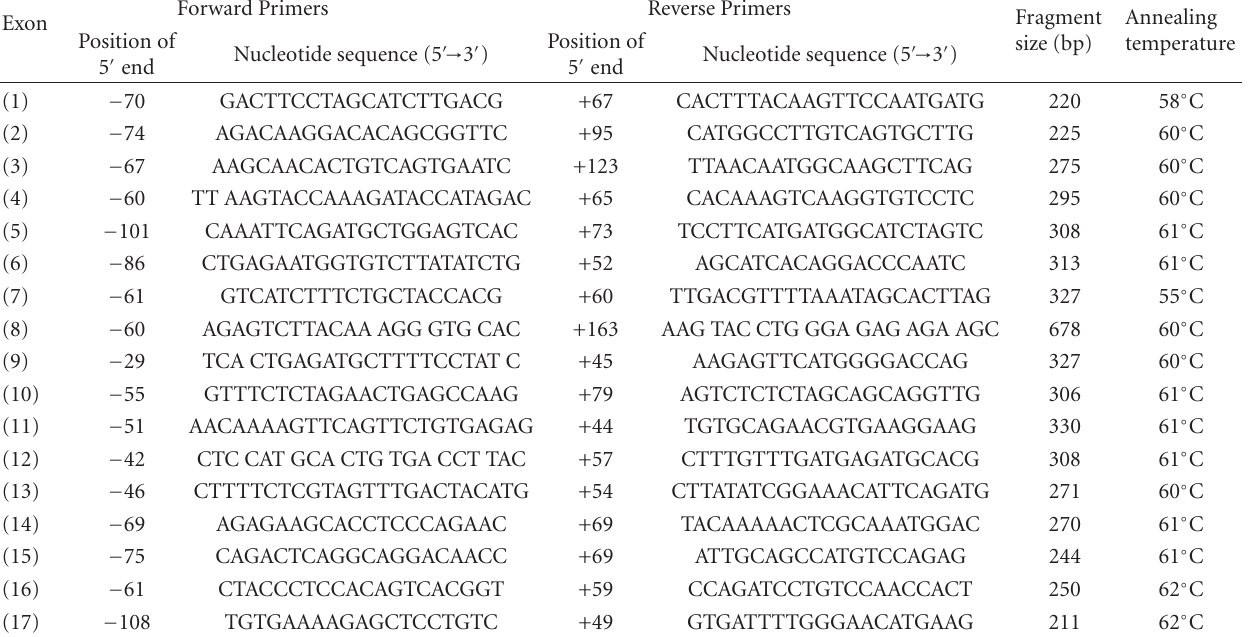
Table 1: Primers used for PCR Amplification of thyroid peroxidase